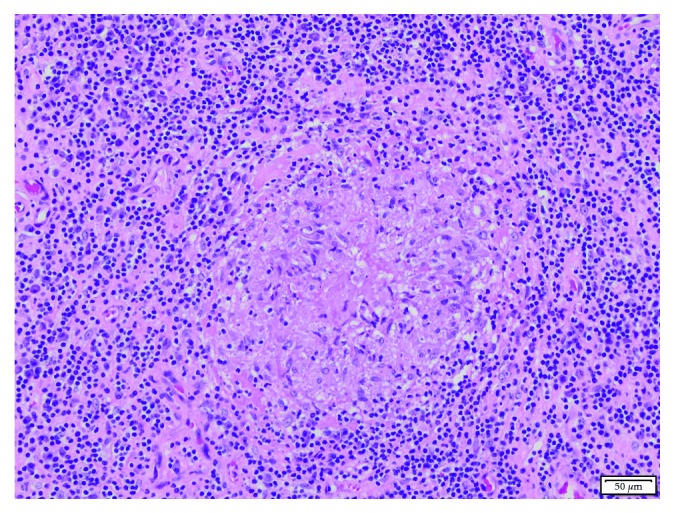
Histopathologic features of excisional biopsy. H/E-stained sections demonstrate mixed chronic inflammation composed of plasma cells and lymphocytes. Scattered granulomas are present with central necrosis (×200).